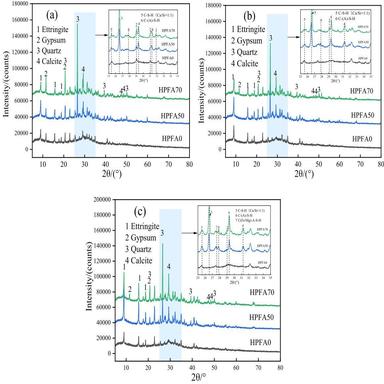
XRD pattern of specimens with different HPFA dosages. (a) 3-day age,(b) 7-day age,(c) 28-day age.1 Ettringite(PDF#01–072–0646),2 Gypsum (PDF#00–033–0311),3 Quartz(PDF#01–089–1961),4 Calcite(PDF#01–076–2712),5 C-S-H(Ca/Si=1:1)(PDF#01–074–7586),6 C-(A)-S-H (PDF#01–088–1135),7 C (Fe/Mg)-A-S-H (PDF#01–087–2482).